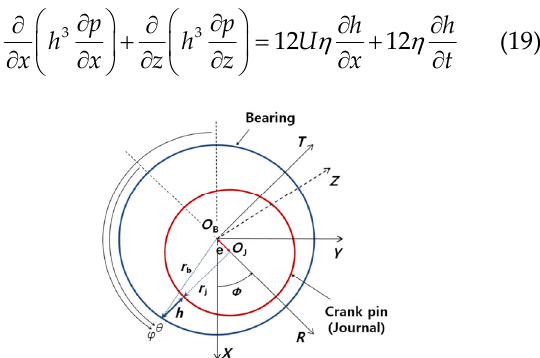
Fig. 3 Schematic diagram of a dynamic loaded crank pin